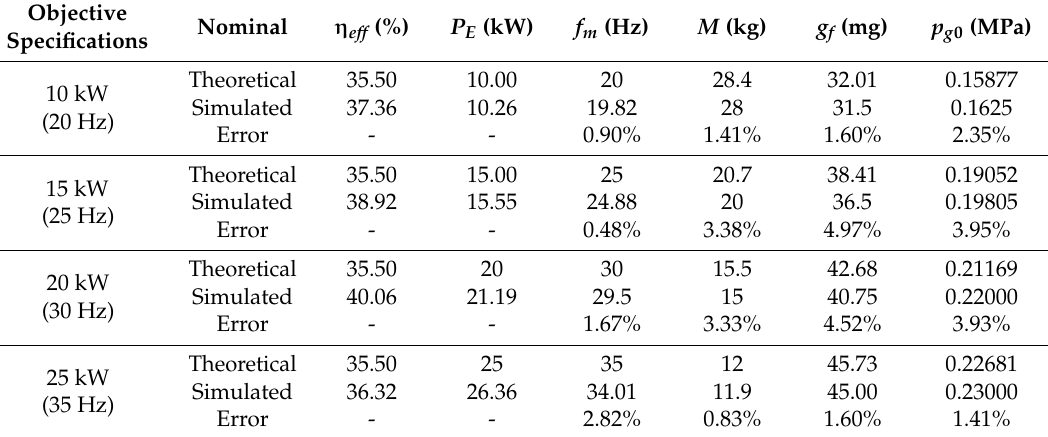
Table 9. Verification and comparison for variable working